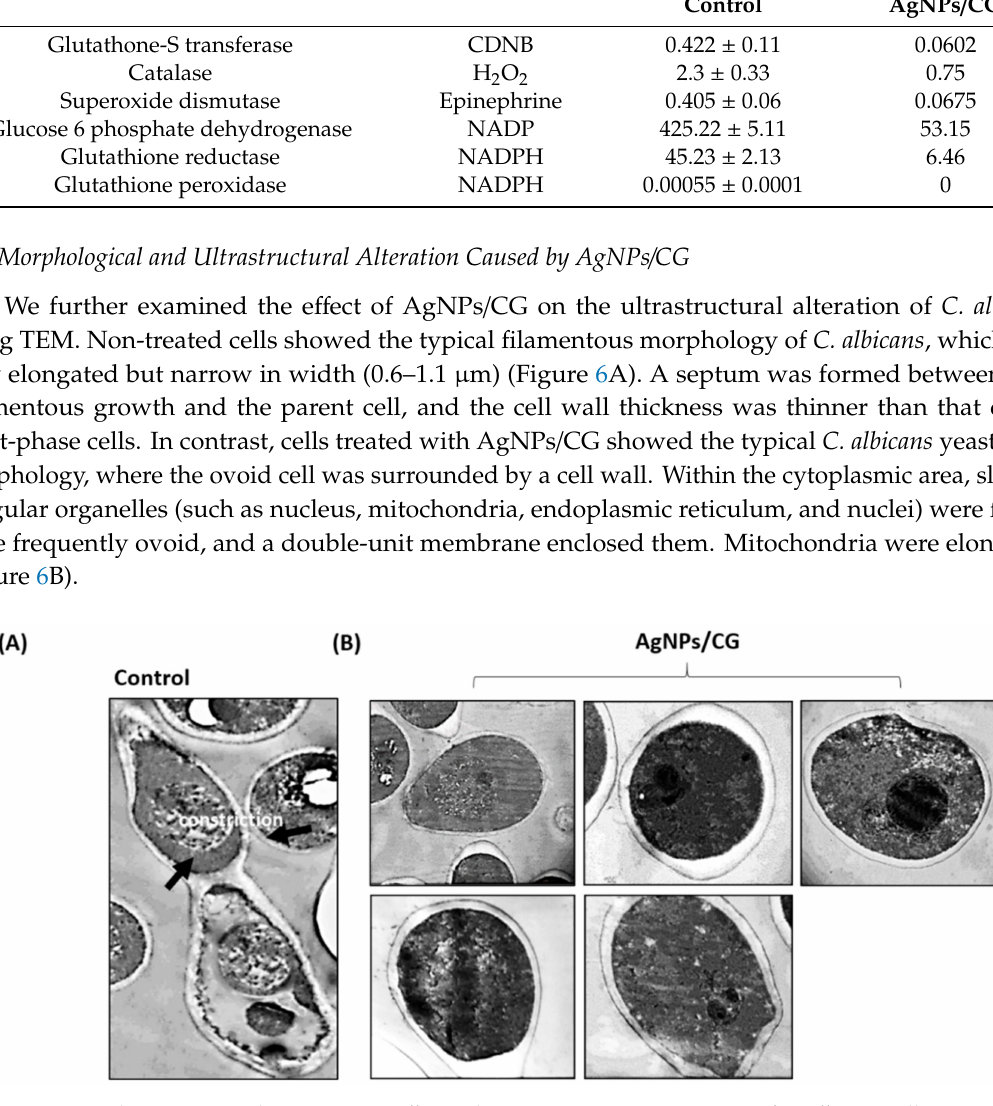
Figure 6. Ultrastructure alteration in C. albicans by AgNPs / CG. TEM images of C. albicans cells treated with AgNPs. ( A ) Yeasts without treatment showing the typical filamentous morphology of C. albicans , which was very elongated but narrow in width (0.6–1.1 µ m). ( B ) Yeast after treatment showing the typical C. albicans yeast form morphology, where the ovoid cell was surrounded by a cell wall after 24 h of incubation and treatment with AgNPs / CG (50 µ g / mL AgNPs + 200 µ g / mL plant